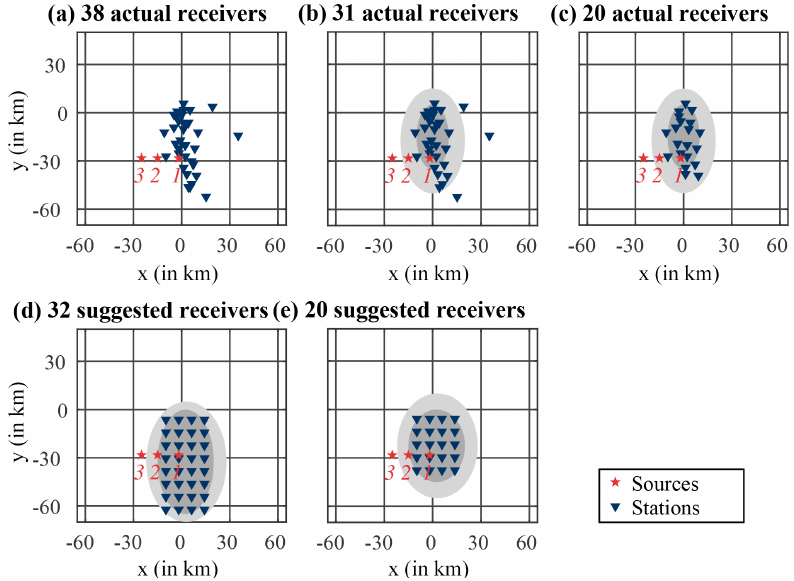
Figure 14. Receiver sets used to test the success rate of locations in southern California: (a) 38 stations as used by Horstmann et al. (2015), (b) a subset of (a) excluding stations that are very close to another station, (c) 20 stations from (a) , (d) 32 suggested stations with regular inter-station distances and (e) 20 stations suggested for optimal results. Three source positions were chosen to test the range of the